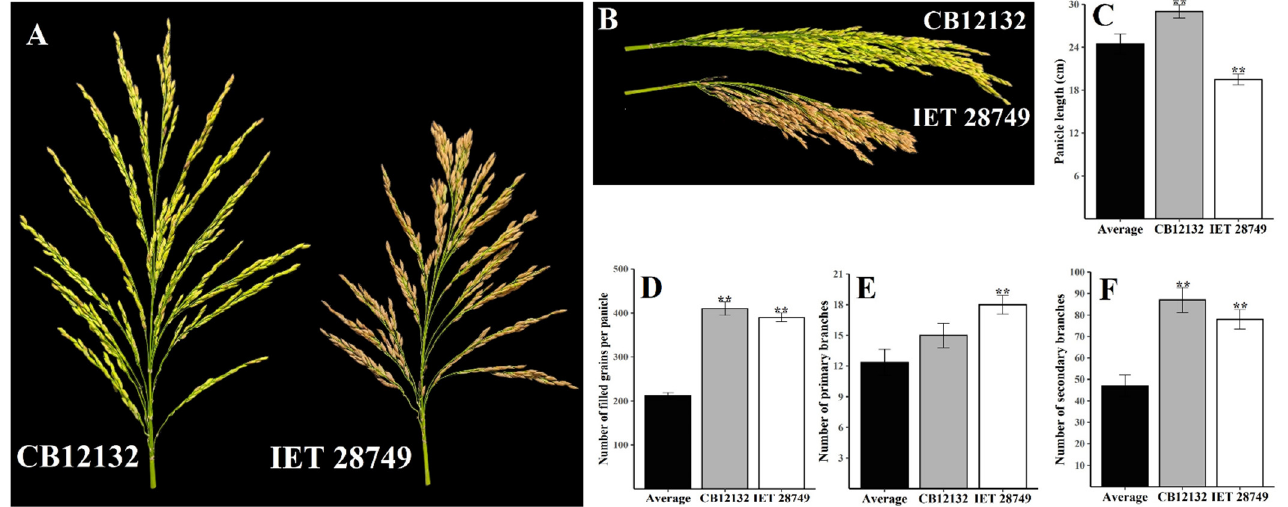
Figure 1. Two new genotypes, i.e., CB12132 and IET 28749, identified for the high number of filled grains per panicle and superior panicle characteristics. ( A , B ) panicle morphology of CB12132 and IET 28749. ( C – F ) Comparison of panicle length, number of spikelets per panicle, number of filled grains per panicle, number of primary branches, and number of secondary branches in CB12132 and IET 28749 with the average value of 50 germplasm over two seasons. Error bar shows standard error ( n = 10); ** indicate 1% significant difference from average compared to the Student’s t -test. values, 52.5 g and 48.935 g, respectively; meanwhile, low values were observed in ACM